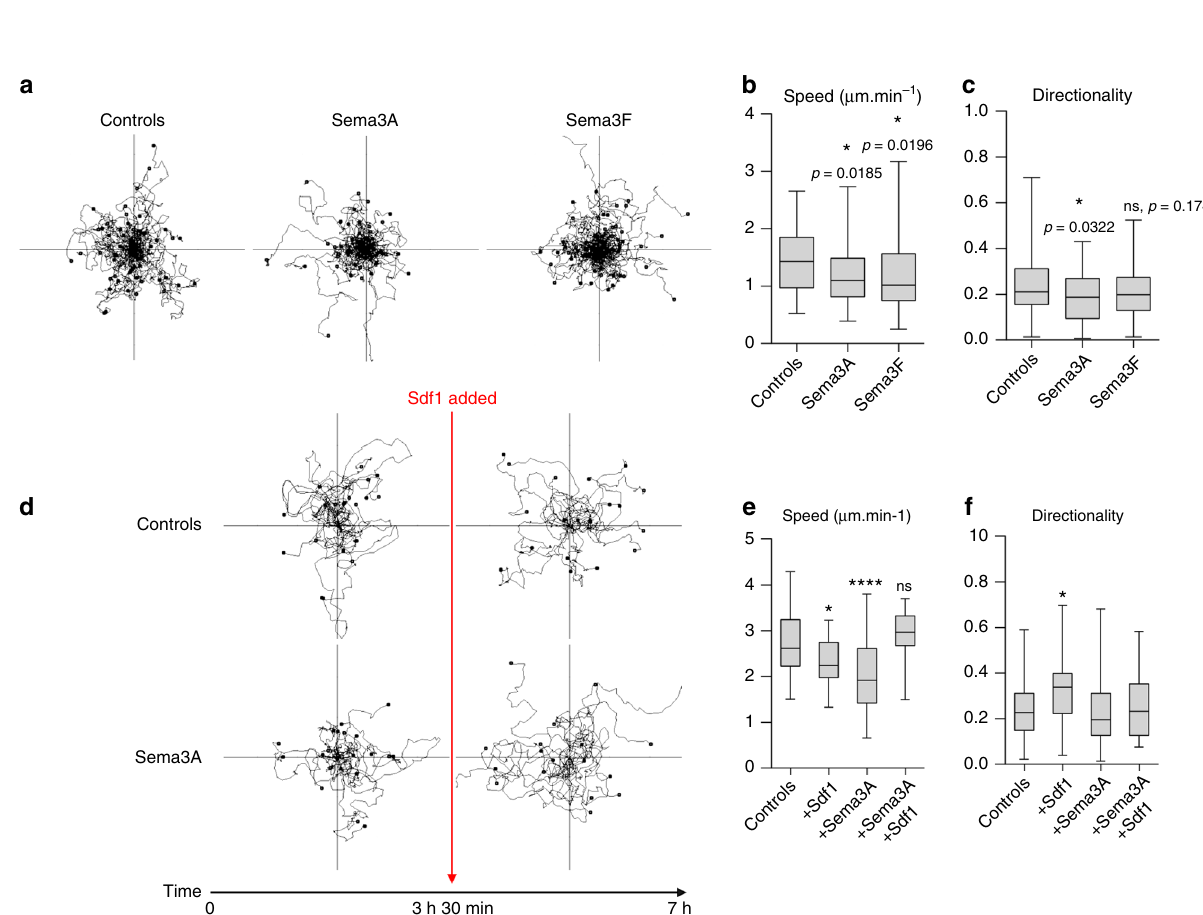
Fig. 5 Sdf1 counteracts Sema3A ’ s effects on single cell motility. a Tracks of single cells on Fibronectin or Fibronectin plus Sema3A. b , c Speed and Directionality in cells shown in a , n = 188 cells ( n controls = 64; n Sema3A = 53; n Sema3F = 71). ANOVA, followed by multiple comparisons. d Tracks of single cells cultured on Fibronectin or Fibronectin plus Sema3A before and after Sdf1 was added in solution. e Speed of cells in conditions shown in d , ANOVA, followed by multiple comparisons; ns, p = 0.621; * p = 0.0188; **** p < 0.0001. f Directionality in cells shown in d , ANOVA, followed by multiple comparisons; * p = 0.0331. Note that Sdf1 reduces slightly speed and increases directionality whereas Sema3A strongly reduces both. Sdf1 restores